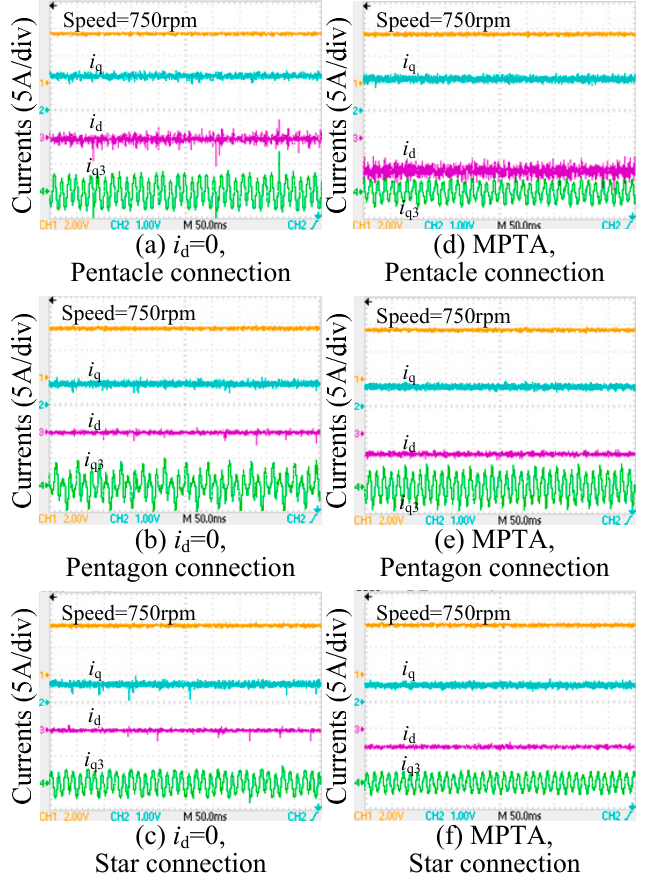
Figure 8. Waveforms of d-q-q 3 frame current as well as the rotor speed under a single open-line fault.